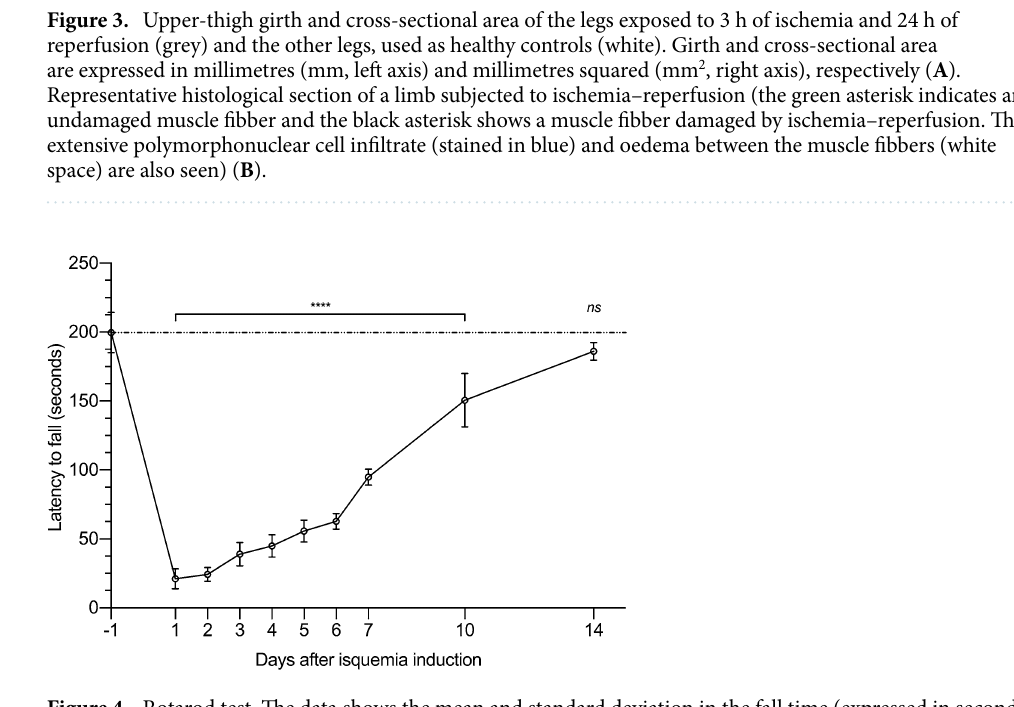
Figure 4. Rotarod test. The data shows the mean and standard deviation in the fall time (expressed in seconds) of the animals subjected to 3 h of ischaemia period; ns (p > 0.05), ****(p <